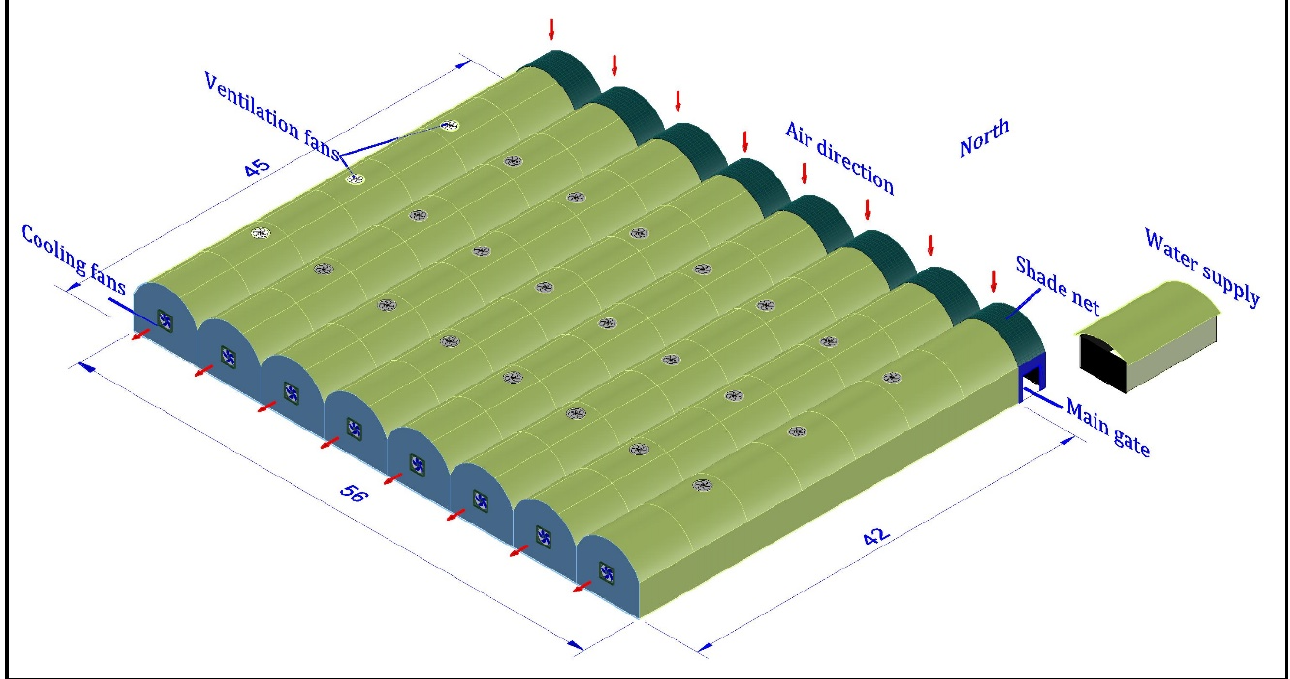
Figure 1. A diagram for the greenhouse from outside with all logistic